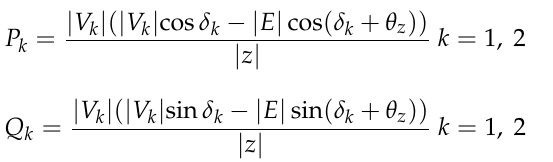
Figure 2. Three-phase two-level inverter output voltage vectors.